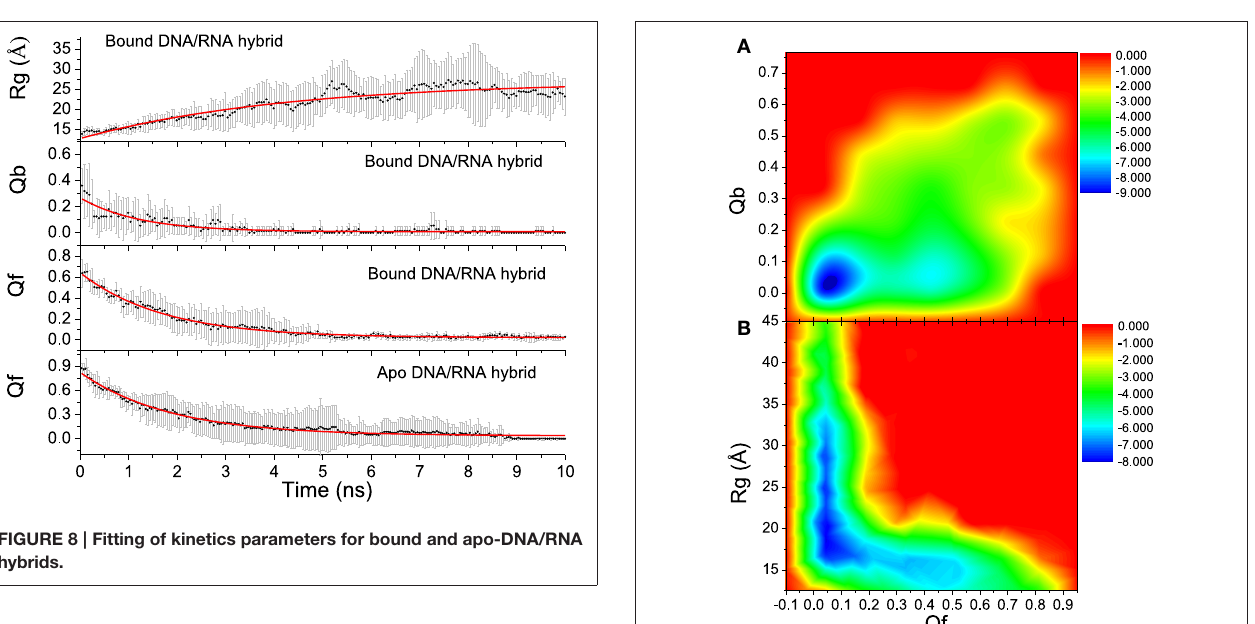
TABLE 3 | Unfolding kinetic constants for bound and apo DNA/RNA hybrid.